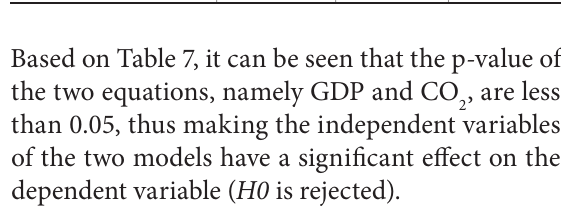
Table 6. Estimation results of the regression coefficient with the dependent variable CO emissions Variables